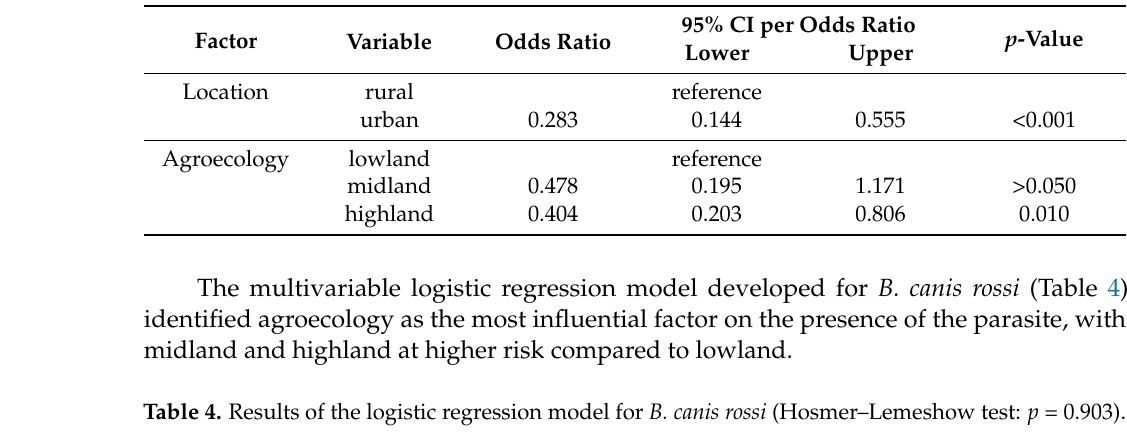
Table 3. Results of the logistic regression model for H. canis (Hosmer–Lemeshow test: p = 0.880).